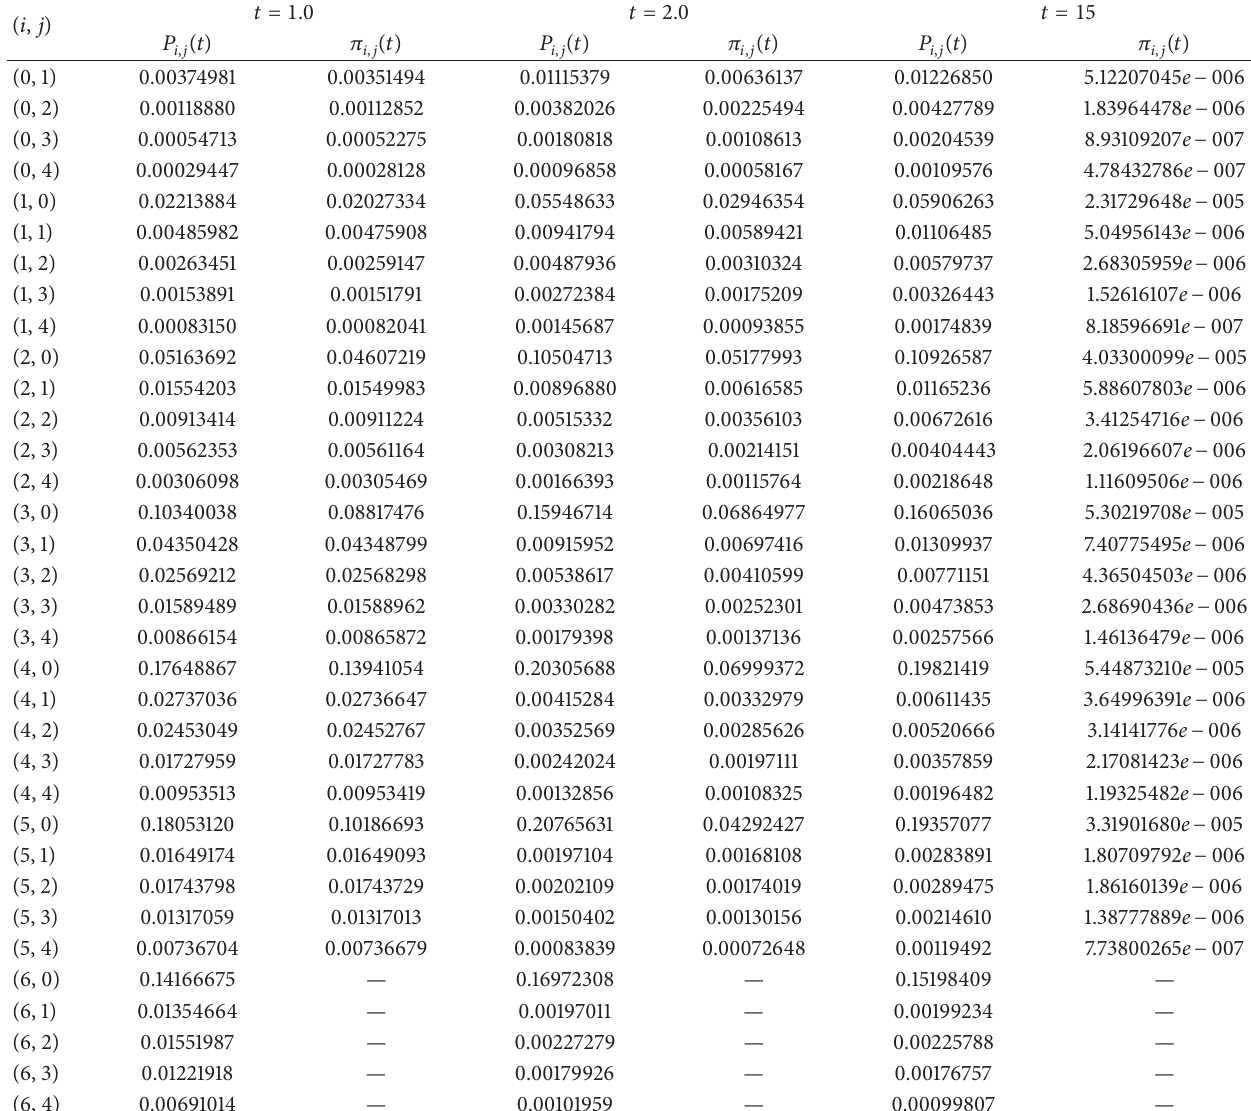
Table 1: State probabilities at time 𝑡 for 5-out-of-10: 𝐺 system with 𝑟 = 2